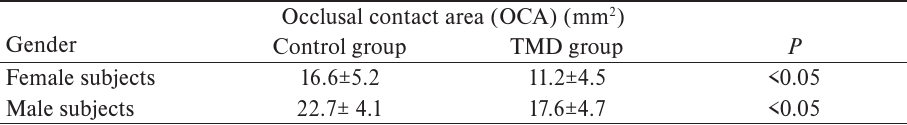
Table 2. Comparative analysis of OCA between female and male subjects of the observed group.